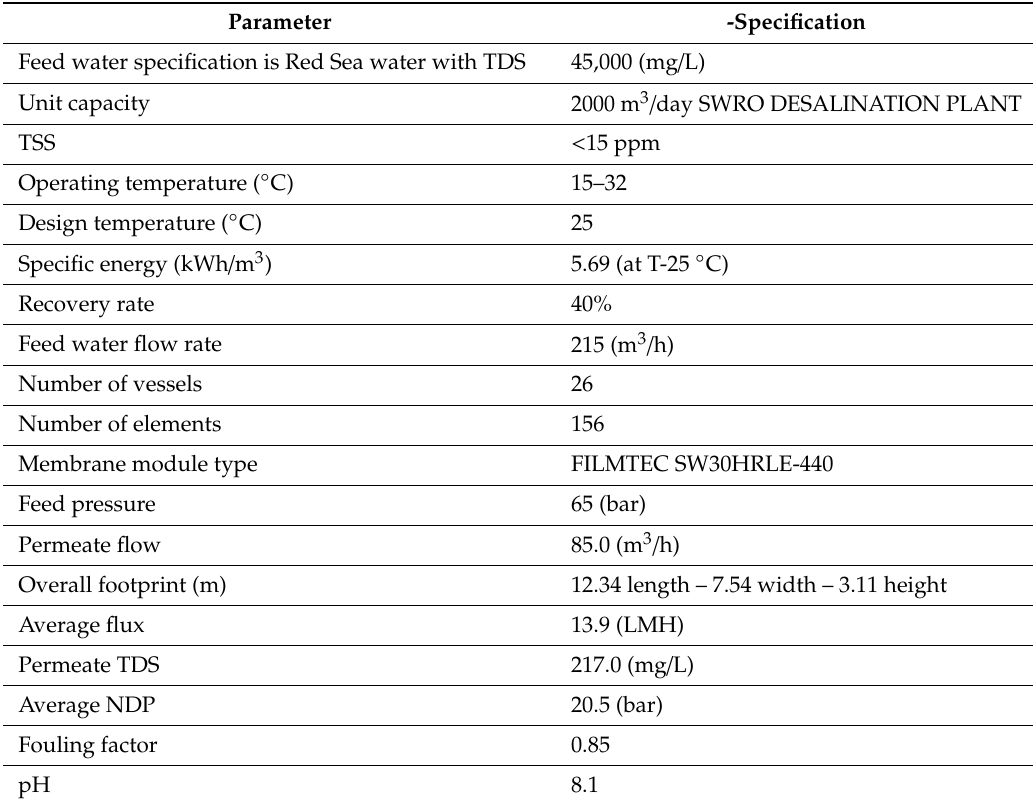
Table 1. Design parameters for each unit of the RO